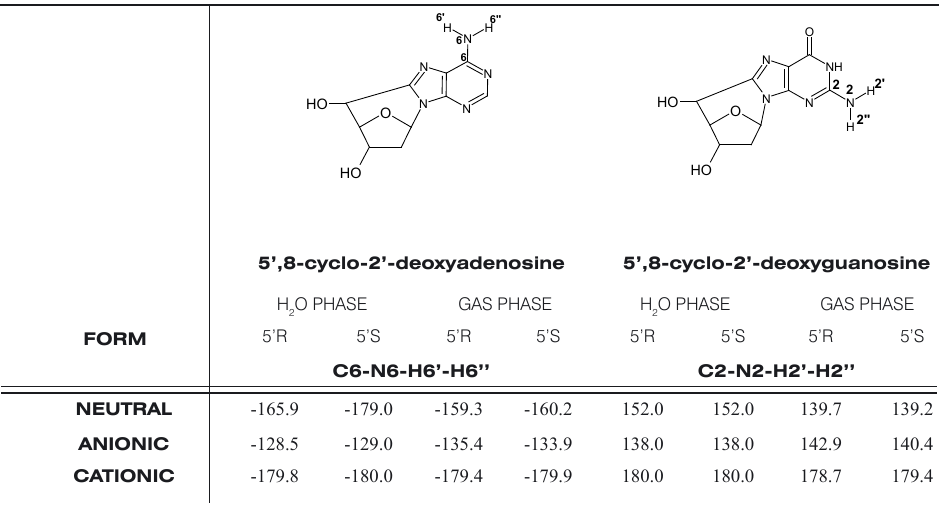
Table 3. Changes in the spatial geometry of the exoamino groups of cyclopurines in their neutral, ionization forms calculated in gaseous and aqueous phase (DFT B3LYP /